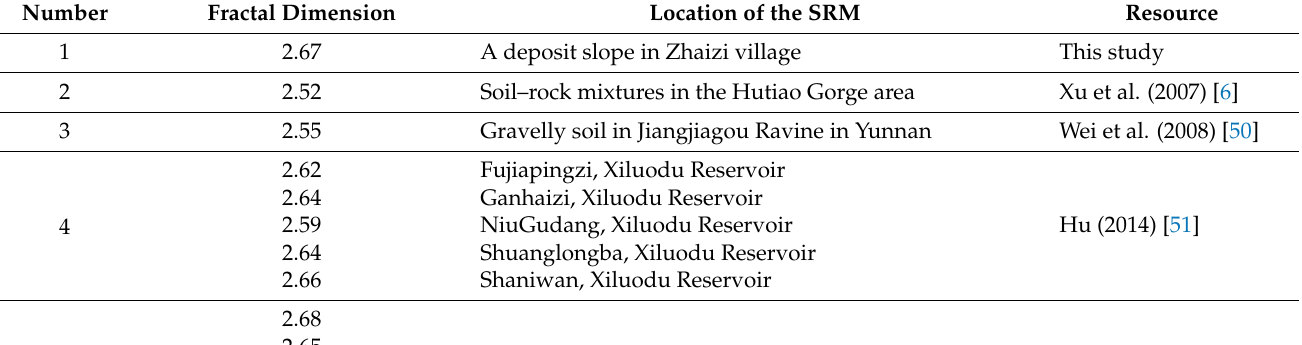
Table 2. Representative fractal dimensions of the SRM in